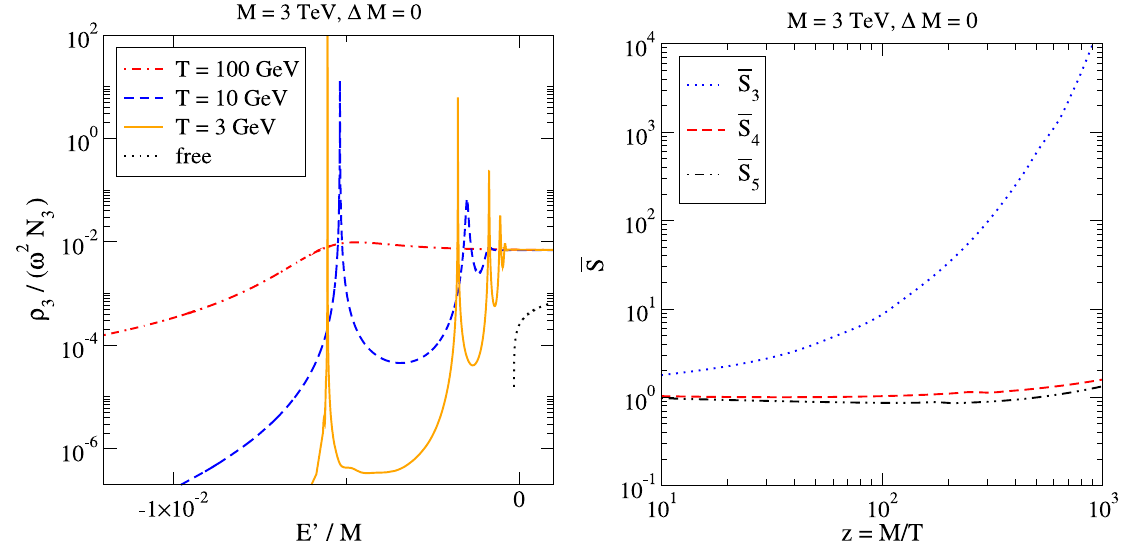
Figure 2 . Left: the spectral function ρ 3 of the scalar pair, interacting via the attractive potential . Here ω 2 M + E ′ . At low temperatures a dense spectrum of bound states can be observed, V 3 ≡ which gradually “melts away” as the temperature increases. Right: the generalized Sommerfeld factors, eq. (4.16), corresponding to the annihilation of the coloured scalars via different channels.